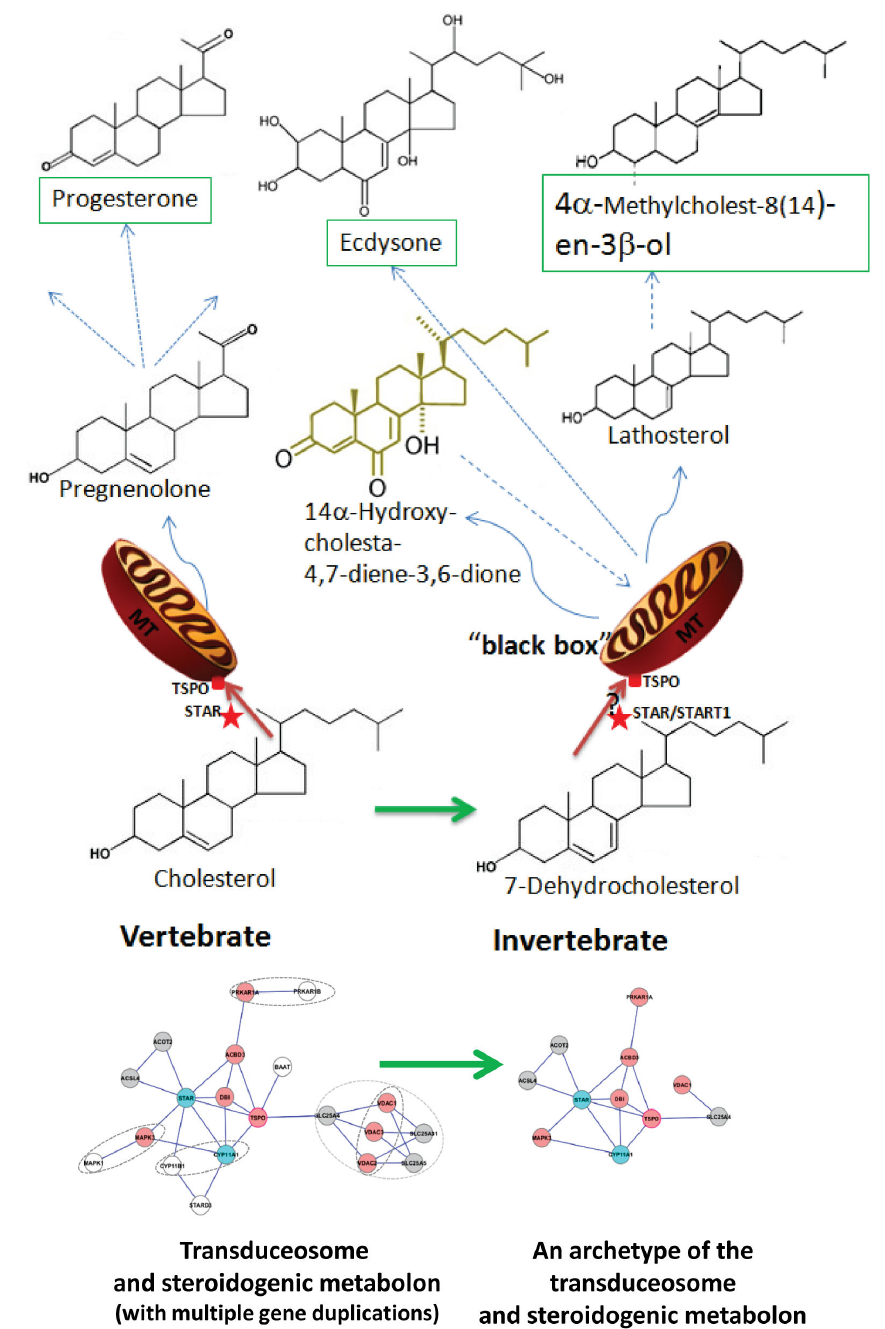
Figure 9. A diagram of the complex of evolutionary steroidogenesis in animals. The main players in the complex, TSPO and STAR, are indicated on the surface of mitochondria. Precursors (cholesterol for vertebrates and 7-dehydrocholesterol for invertebrates), and first metabolites (pregnenolone for human and lathosterol for worms), intermediate metabolites (progesterone), and/or final products (ecdysone for insects) are indicated. The “black box” refers to the initial steps of steroidogenesis in insects as the enzymes in this process are unknown [100]. The predicted functional interaction networks of the proteins involved in the complex was generated using version 9.0 of the STRING database [101]. The dotted oval circles indicate the gene duplication event. Red indicates the gene is conserved from mammals to invertebrates, light blue indicates genes with sequence divergence but with similar biological function, grey indicates genes with divergence in both sequence and function, and white indicates that the duplicated gene may not be involved in the complex. doi: 10.1371/journal.pone.0076701.g009 PLOS ONE |